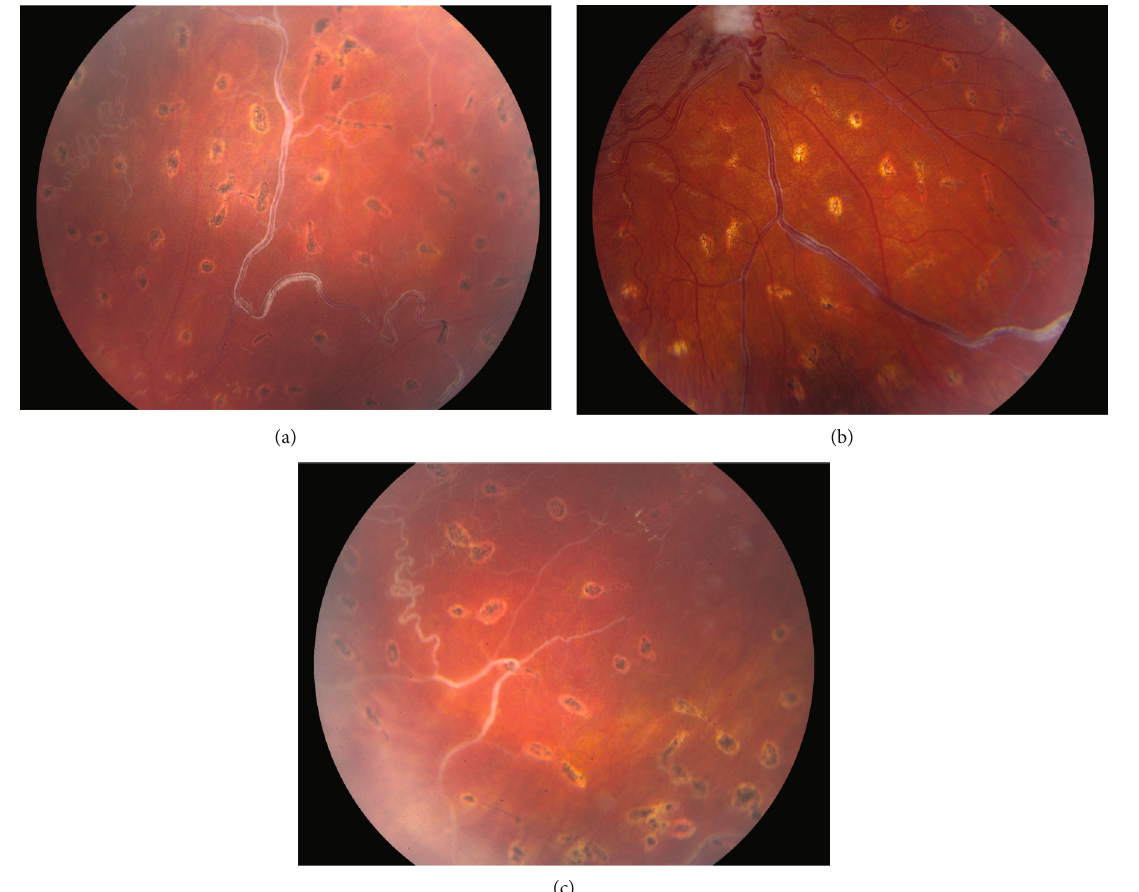
Figure 2: Silver wiring of the retinal veins in the superior (a), inferior (b), and temporal quadrant of the retina (c).